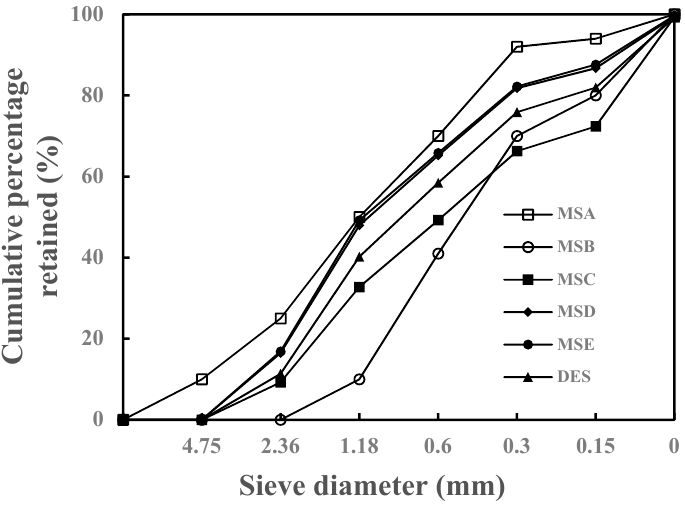
Figure 3. Gradation curves of six sands.